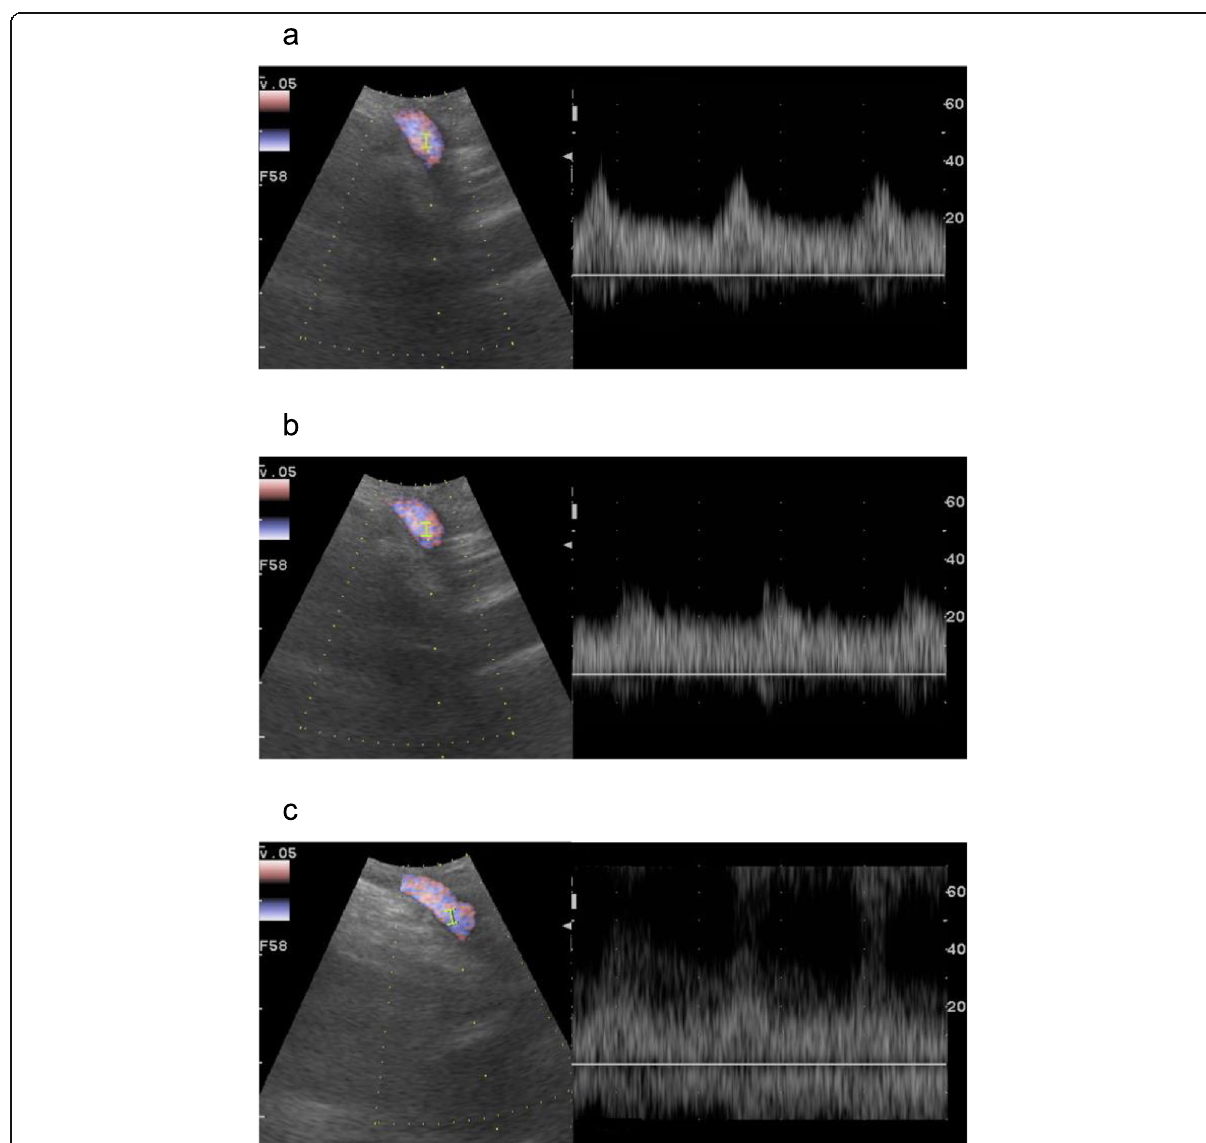
Fig. 5 Assessment of the hepatic arterial blood flow with intraoperative doppler ultrasonography. a Hepatic arterial blood flow before the GDA clamping test. The acceleration time was 143 ms and resistive index was 0.531. b Hepatic arterial blood flow after the GDA clamping test. Acceleration time decreased to 60 ms and resistive index decreased to 0.428, suggesting no tardus-parvus pattern with the GDA clamping. c Hepatic arterial blood flow at the end of the operation. Acceleration time was 144 ms and resistive index was 0.537, suggesting no